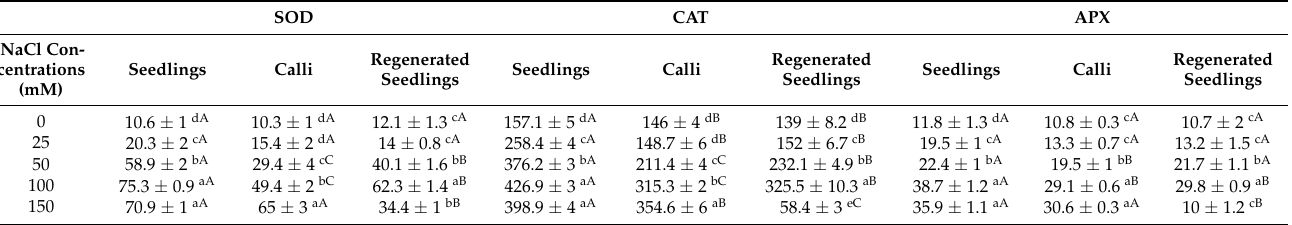
Table 7. Comparison of the activity of SOD, CAT, and APX in three explants of Carum copticum under five NaCl